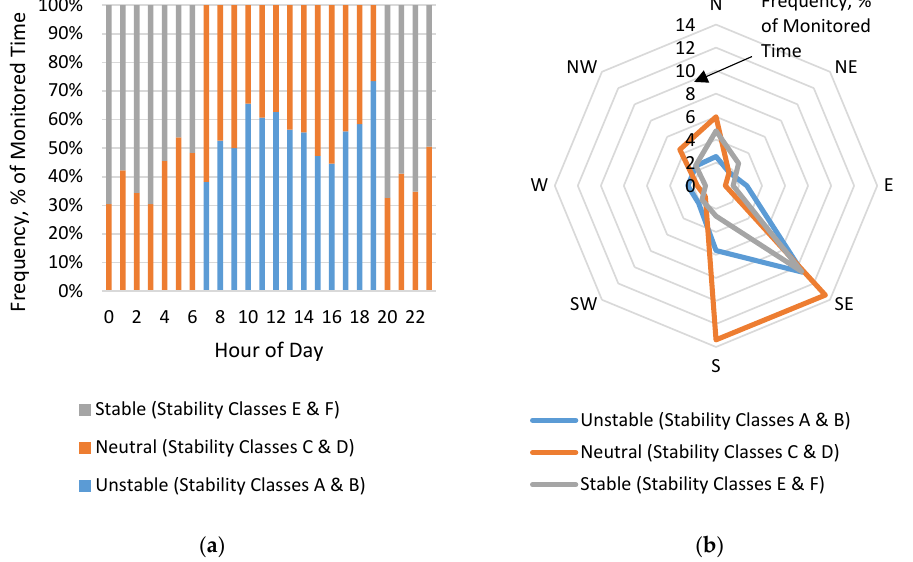
Figure 3. Frequency (% of measurement period) of wind measurements for the dairy case study, classified by: ( a ) hour of day and Pasquill – Gifford stability classes; and ( b ) wind direction and stability class.